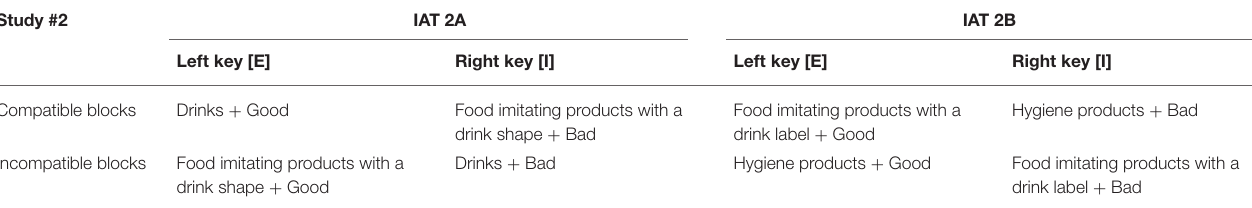
TABLE 4 | Response mappings in IATs 2A and 2B.